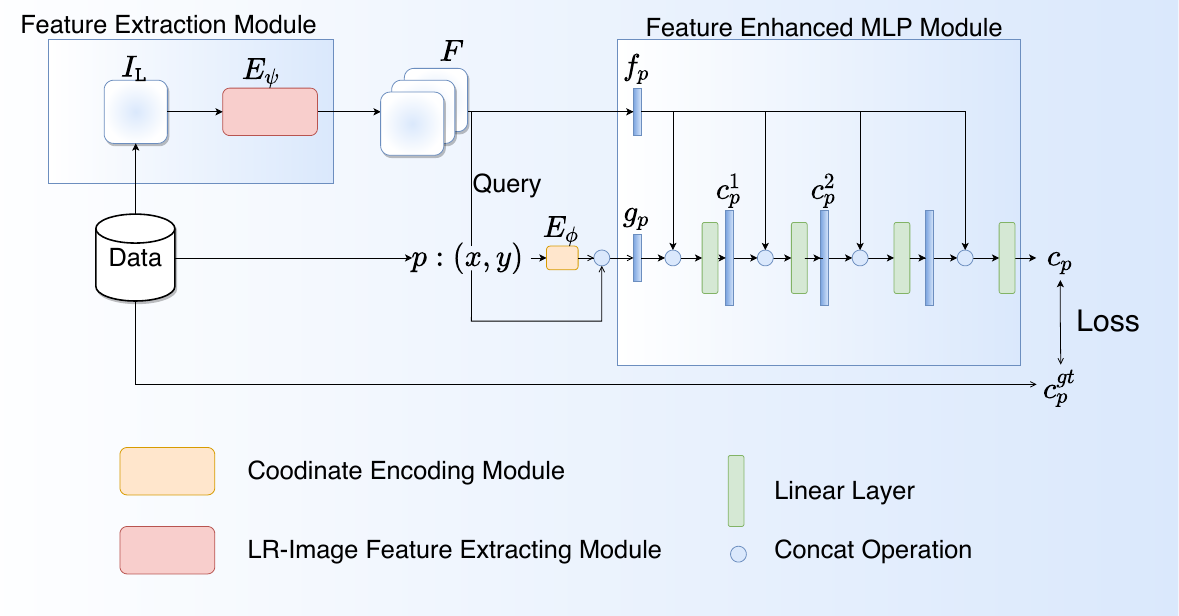
Figure 2. The architecture of the proposed model. The blue rectangles indicate the feature vectors corresponding to the coordinates.